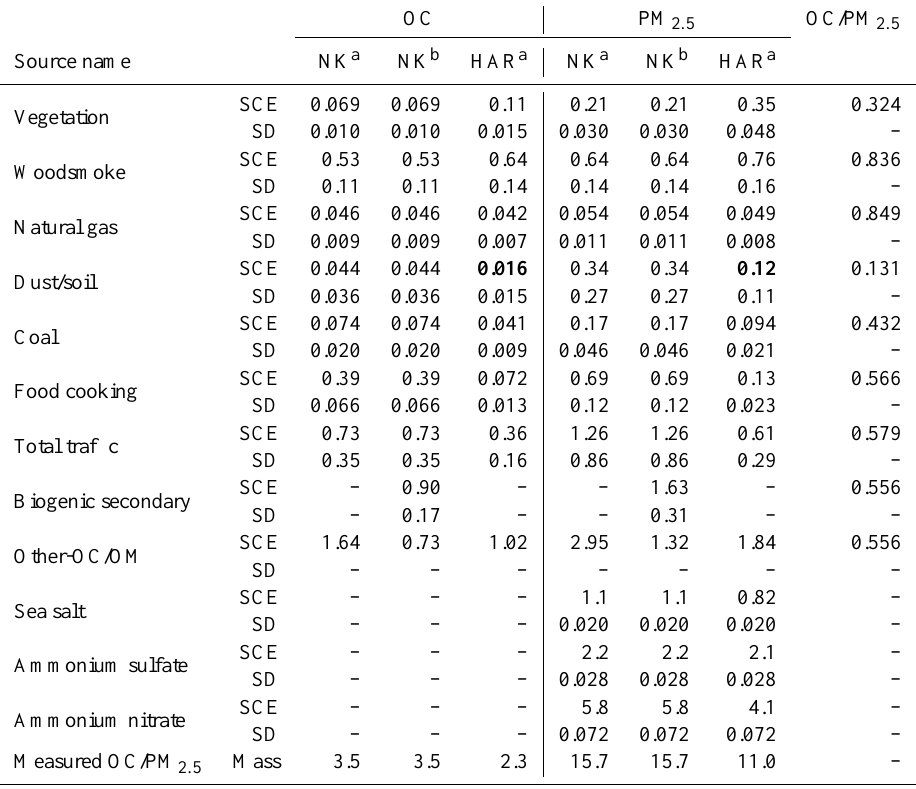
Table 4. Source contribution estimates (SCE) (µgm − 3 ) and standard deviation (SD) for fine-particulate OC and PM 2 . 5 at NK and HAR from the CMB